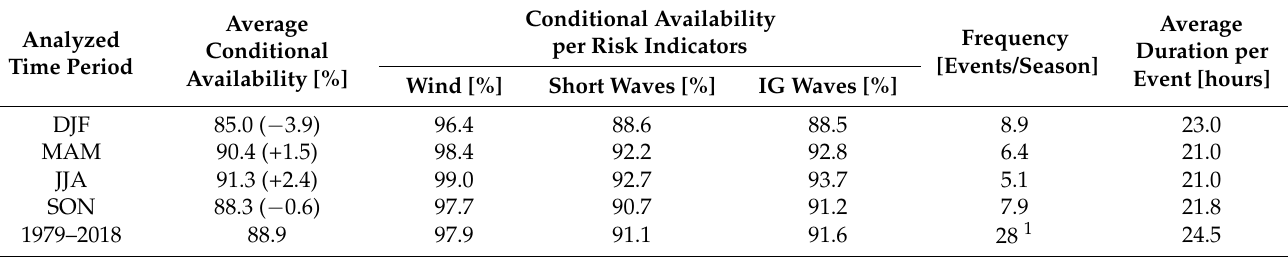
Table 5. Overview of seasonality effects (DJF/MAM/JJA/SON) on globally averaged overall conditional availability. Analyzed Time